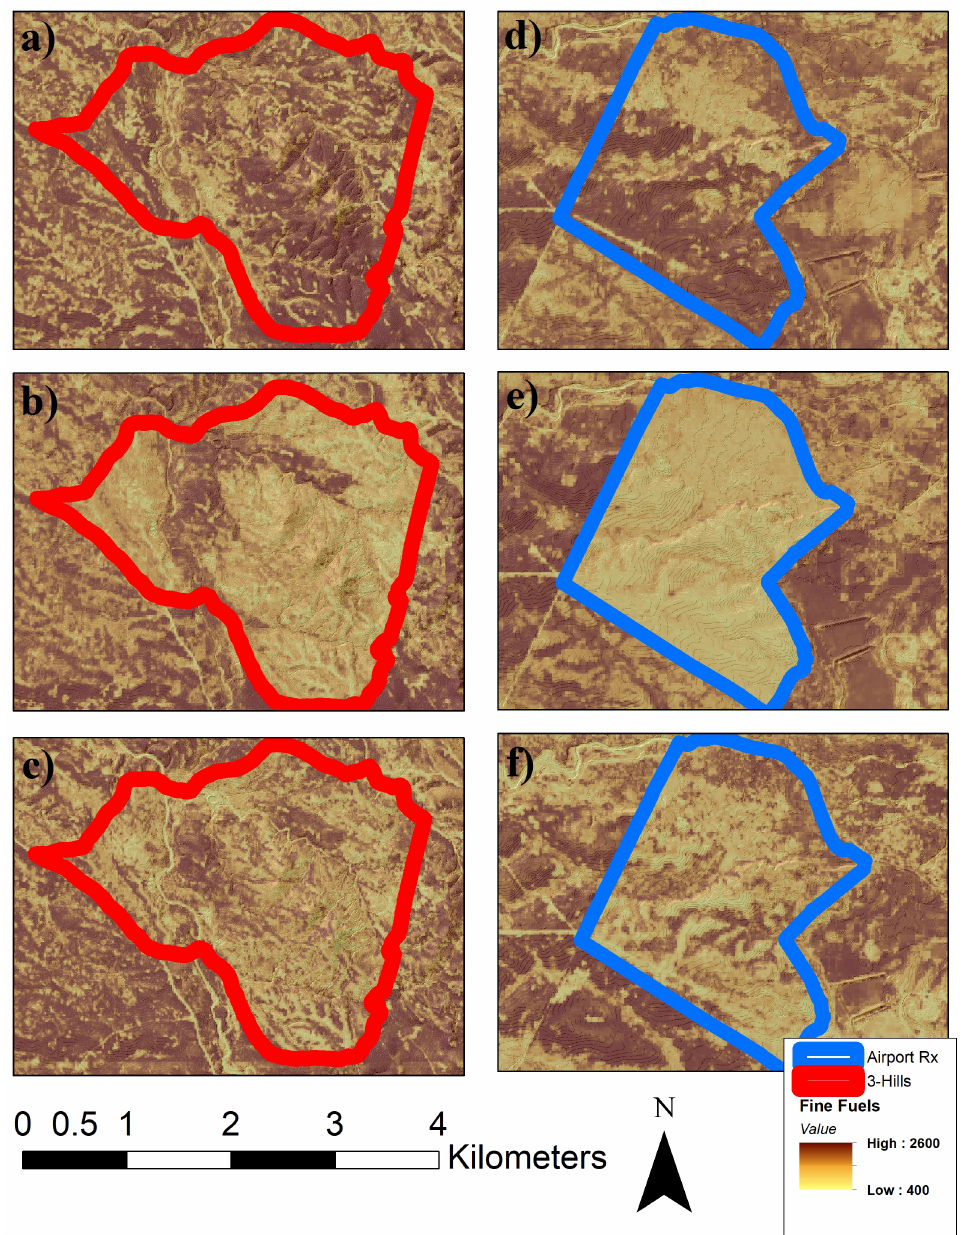
Figure 5. Change in fine-fuels associated with 3-Hills wildfire (red polygons) in July 2016 and the Airport prescribed fire (blue polygons) in June 2016 within BANWR based on Sentinel-2A estimates of fine-fuels showing ( a , d ) pre-fire year, ( b , e ) first-year post fire, and ( c , f ) fuel recovery in the third-year post